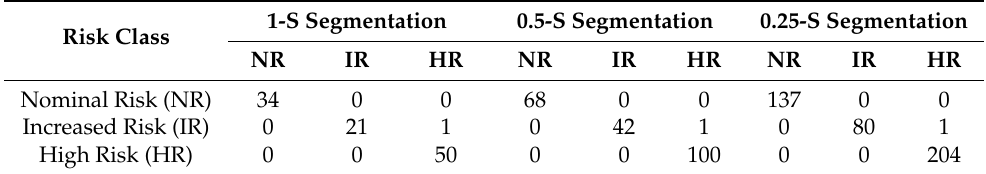
Table 5. Confusion matrix of classification results from Decision